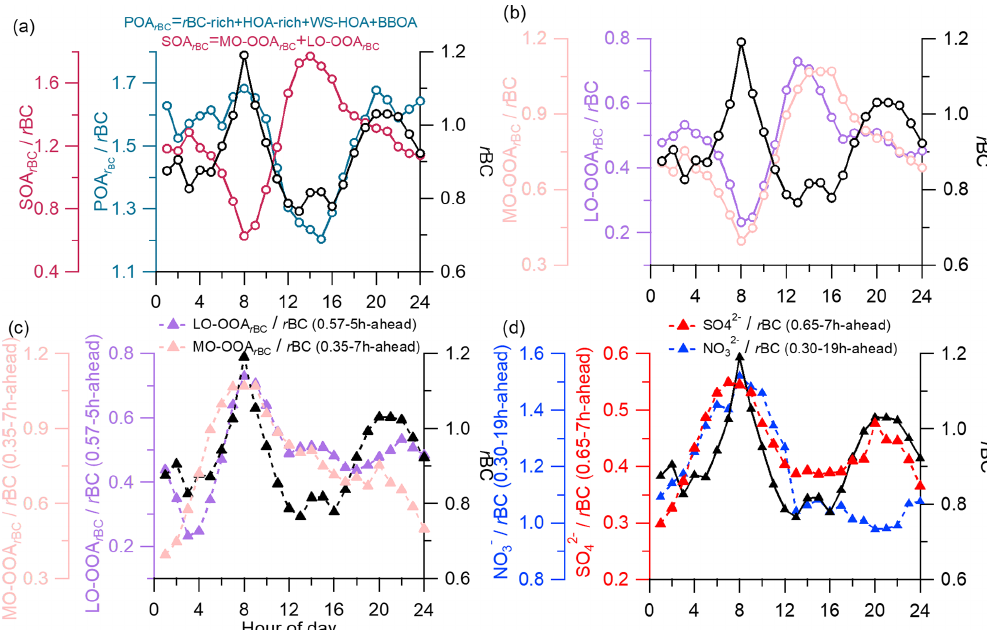
Figure 10. Campaign-average diurnal patterns of (a) rBC, POA rBC / rBC and SOA rBC / rBC and (b) rBC, MO-OOA rBC / rBC and LO- OOA rBC / rBC. Diurnal patterns adjusted for the average coating time (ACT) for (c) LO-OOA rBC / rBC and MO-OOA rBC / rBC and for / rBC and NO − / (d) SO 2 − 4 3